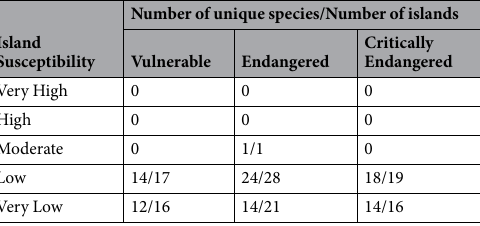
ble islands are Brachylophus fasciatus (Fiji banded iguana), Emballonura semicaudata (Pacific Sheath-tailed Bat), Emoia adspersa (Micronesian Skink), Emoia boettgeri (Micronesia Forest Skink), Emoia lawesi (Olive Small-scaled Skink), Emoia trossula (Viti Barred Treeskink), Perochirus ateles (Micronesia Saw-tailed Gecko) and Pteropus mar- iannus (Marianas Flying Fox) .